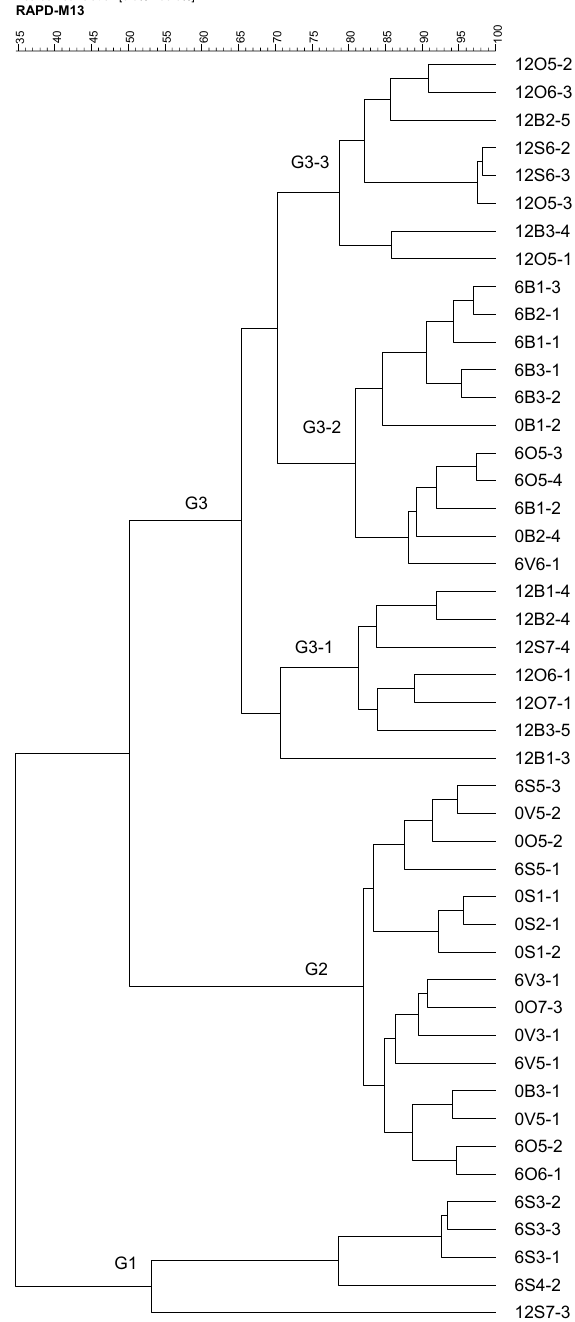
Figure 2. Pearson coefficient-based analysis of the RAPD profiles of the strains isolated. The initial number indicates the week of